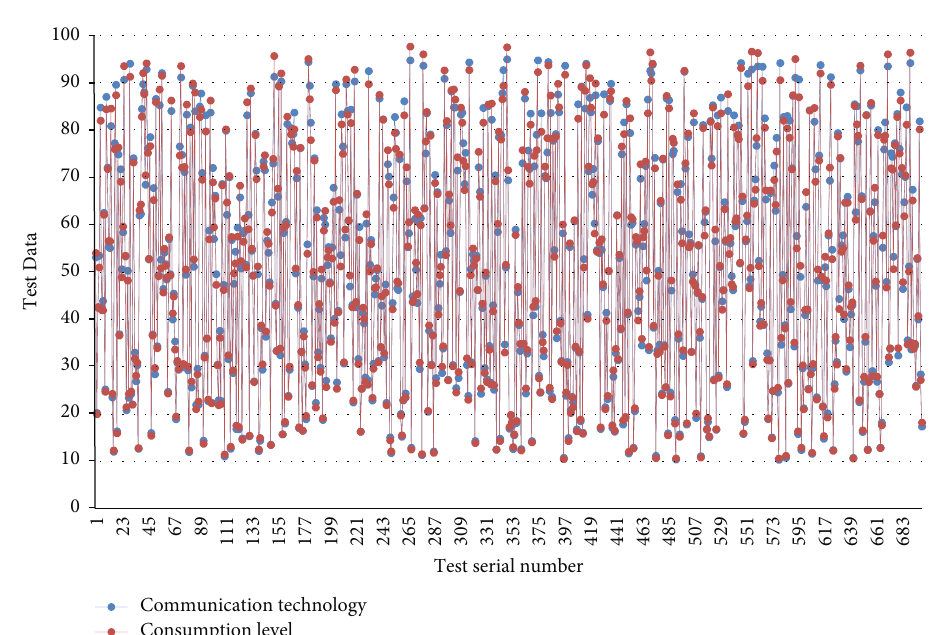
Figure 8: Cluster analysis of the correlation between the development of communication technology and consumer